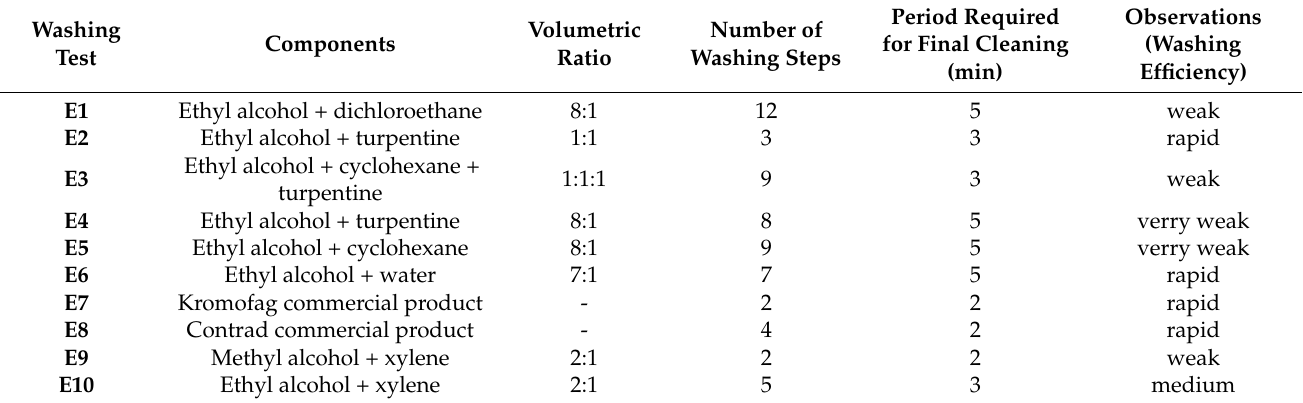
Table 3. Efficiency of wet cleaning systems in the wash